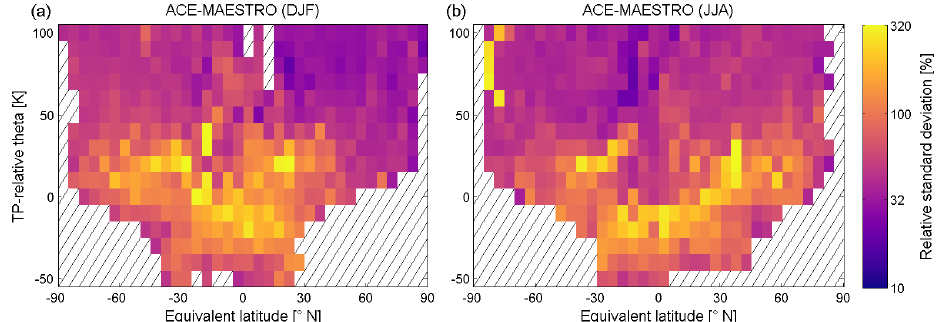
Figure 7. Alternative view of the MAESTRO ozone relative standard deviation, as first presented in Fig. 4k and l, with panel (a) here corresponding to Fig. 4k and likewise panel (b) corresponding to Fig. 4l. Note the shift to a logarithmic colour scale to better display the variability and the addition of hatching to the plots where there are no data